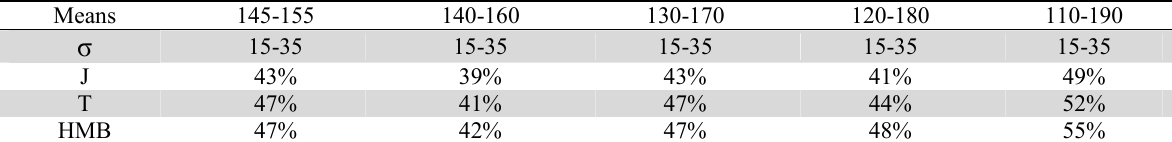
Comparison of the IM for variable variance (The number of machines = 2, The number of Jobs = 10)